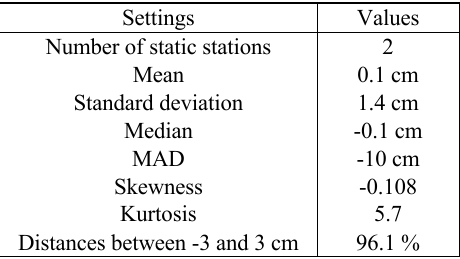
Table 8. Results for the isolated room